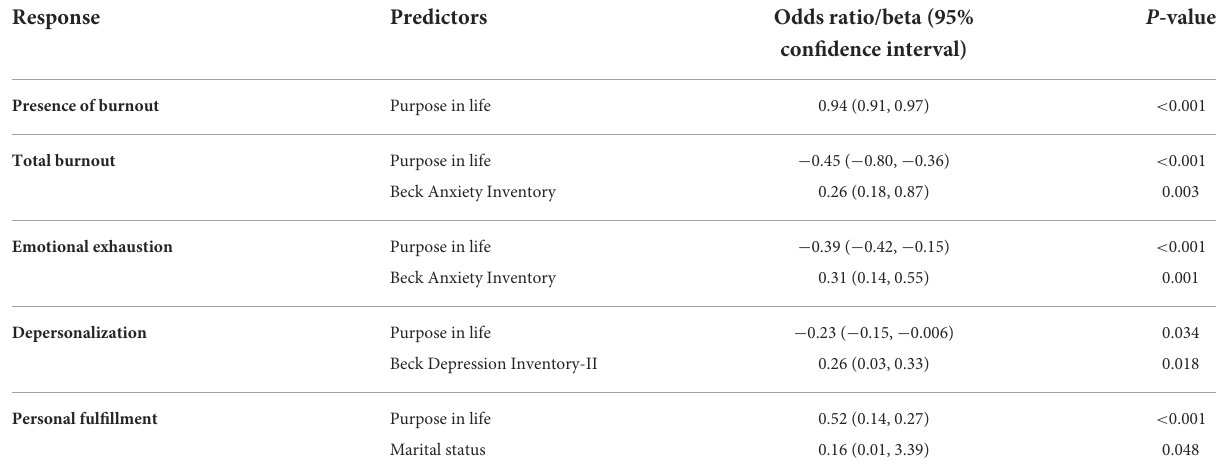
TABLE 3 Significant odds ratios from logistic and linear regression models predicting